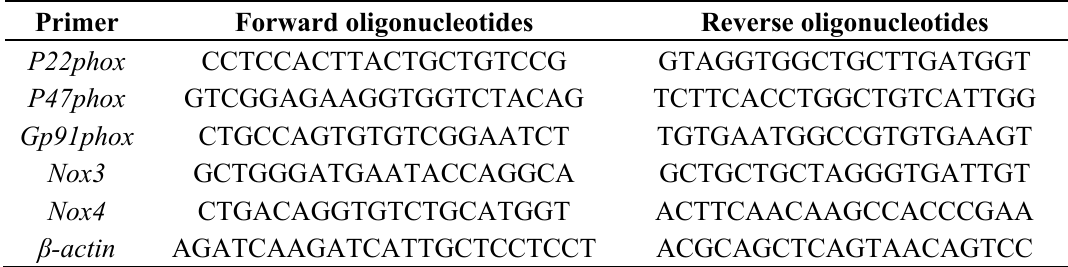
Table 1. Primers used for real-time